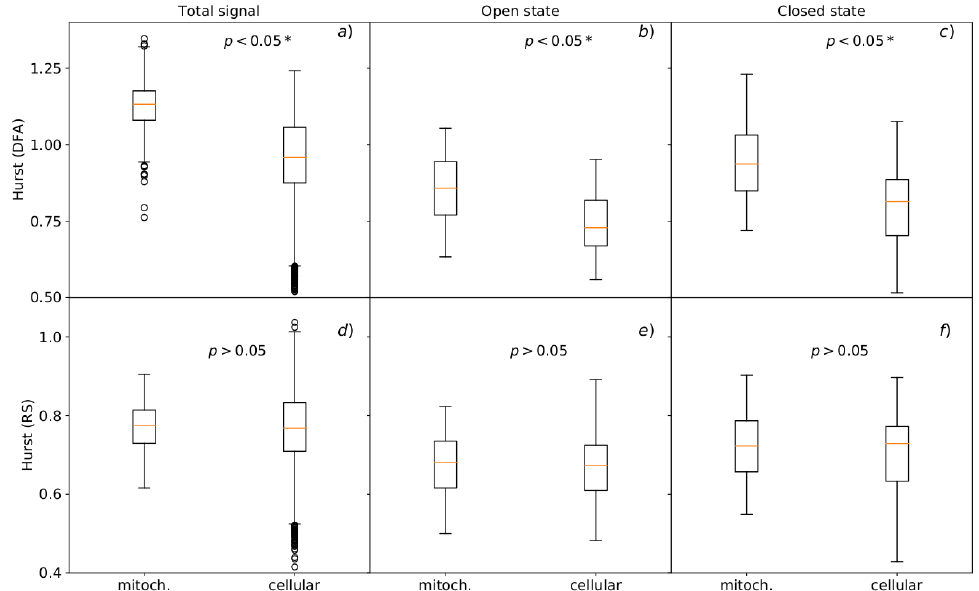
Figure 6. Hurst exponents obtained by the standard R/S and generalized DFA methods for the data describing single-channel currents of BK channels from patches of mitochondrial and cellular membranes. The upper panels ( a – c ) present the results obtained at membrane hyperpolarization; the lower graphs ( d – f ) show the data obtained at membrane depolarization. The boxes extend from the lower to upper quartile values. The line inside each box characterizes the median value and the whiskers represent the range of data. Outlier points are those which exceed the ends of the whiskers. For the currents corresponding to the closed channel’s states we obtained H mito =